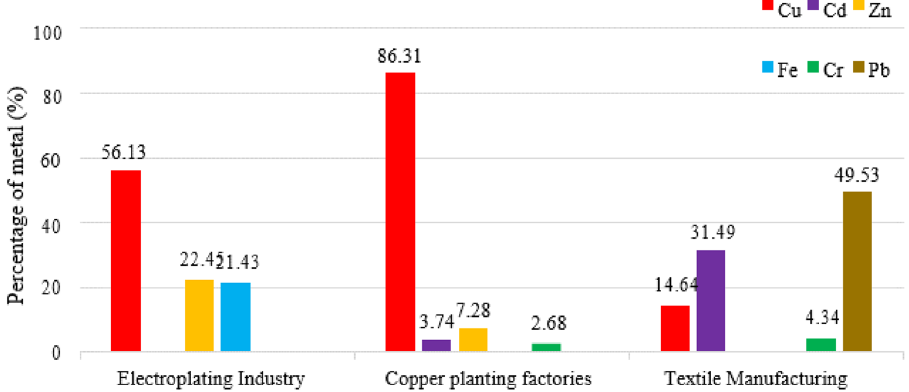
Fig. 1 Heavy metals present in industrial manufacturing